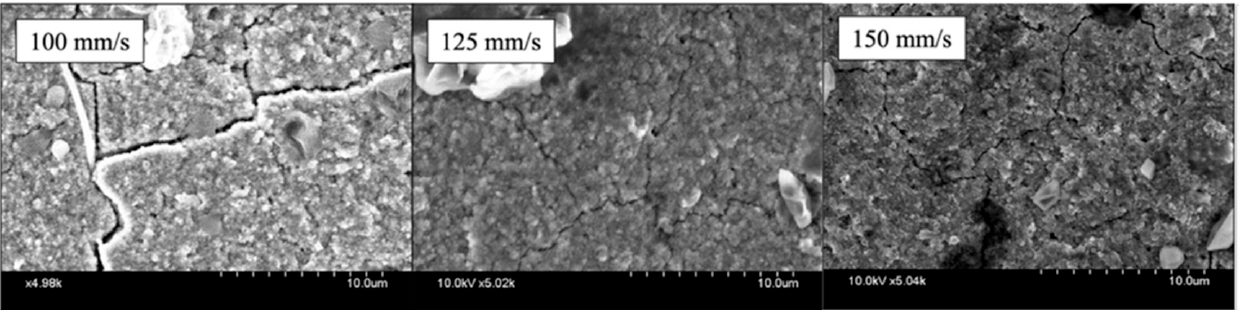
Figure 14. SEM morphologies (magnification 5k×) of 2W sintered thin films with scanning speed 150mm/s, and frequencies 90k Hz ( a ), 105k Hz ( b ), and 120k Hz ( c ). 3.3. XRD Analysis Besides morphology, XRD analyses assisted us to obtain a better understanding of the reaction of UV laser to the NiO particles and the mechanism of cracks. The XRD pat- terns of NiO thin films are shown in Figure 15. These detected 2 θ at 37.2 ° , 43.3 ° , 62.9 ° , 75.5 ° , and 79.5 ° respond to the diffraction signals of crystal planes (111), (200), (220), (311), and (222), respectively. Since XRD penetrated the thin films and reflected the signal of ITO electrodes, there were redundant peaks that represented the diffraction of the ITO elec- trodes and glass substrate at 2 θ at 30.32 and 35.22, although the XRD operation was a grazing incidence small angle. Yet, these unwanted signals did not take effect on the NiO peaks and could be ignored. The 2 θ results illustrated that there were no redox reactions in NiO, and unpredictable peaks did not appear. Moreover, the diffraction intensities en- hanced as the UV laser energy absorption increased. This phenomenon indicated the sig- nals of crystal planes were enhanced because of the increasing combination of particles; however, Figure 15 shows the intensity slightly declined in the experimental group of 2.5